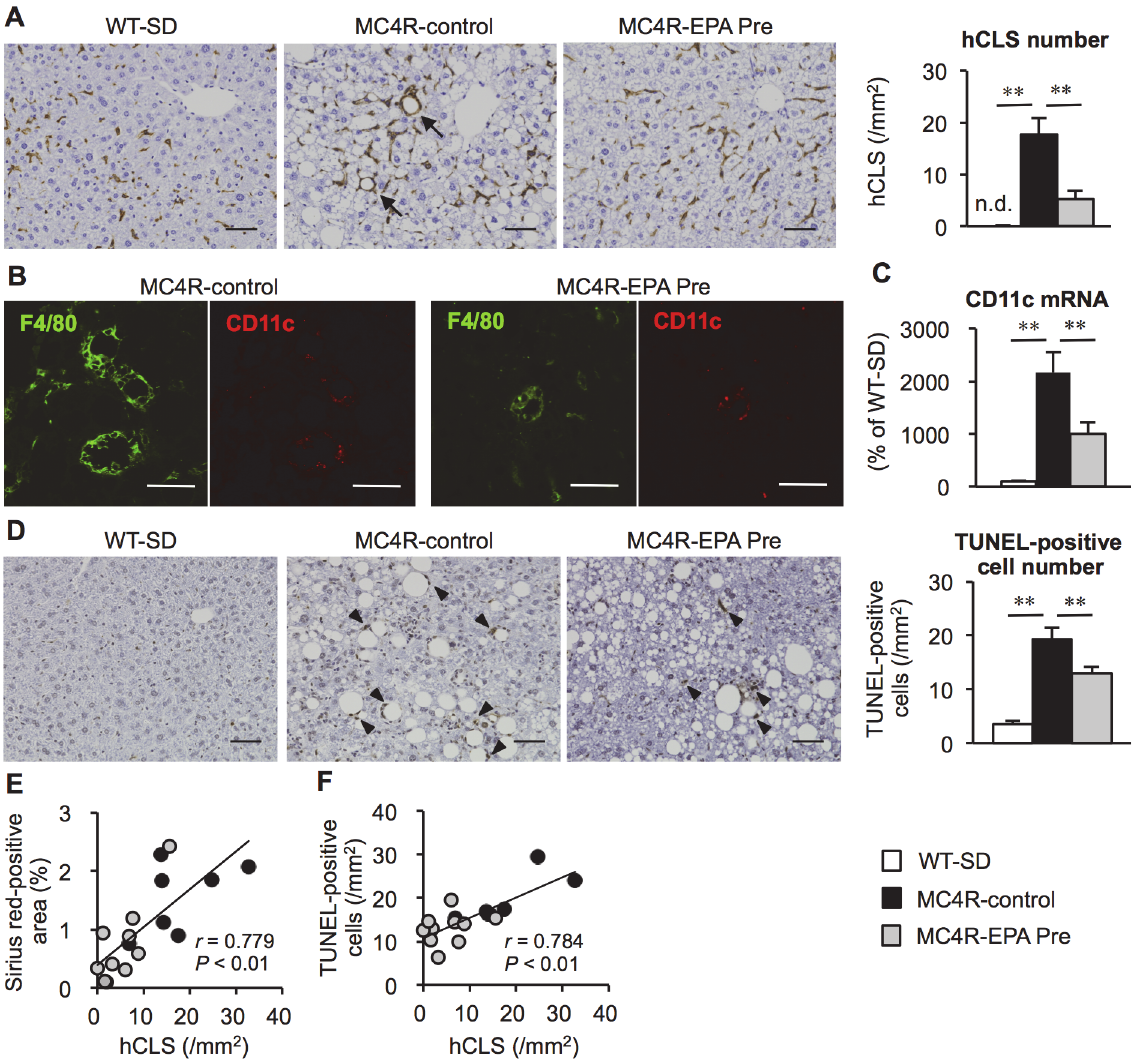
Fig 4. Effect of EPA on hCLS formation and apoptosis in the liver of MC4R-KO mice. (A) F4/80 immunostaining of the liver after 24 weeks of EPA treatment. Arrows indicate characteristic histological features termed “ hepatic crown-like structures (hCLS) ” . (B) Immunofluorescent staining for F4/80 (green) and CD11c (red). (C) Hepatic mRNA expression of CD11c. (D) TdT mediated dUTP-biotin nick end labeling (TUNEL) immunostaining and the number of TUNEL-positive cells. Arrowheads indicate TUNEL-positive cells. Correlation of the number of hCLS and the fibrosis area (E) and the number of TUNEL-positive cells (F). Scale bars, 50 μ m. * P < 0.05; ** P < 0.01; n.d., not detected. WT-SD, n = 8; MC4R-control, n = 7; MC4R-EPA Pre, n =